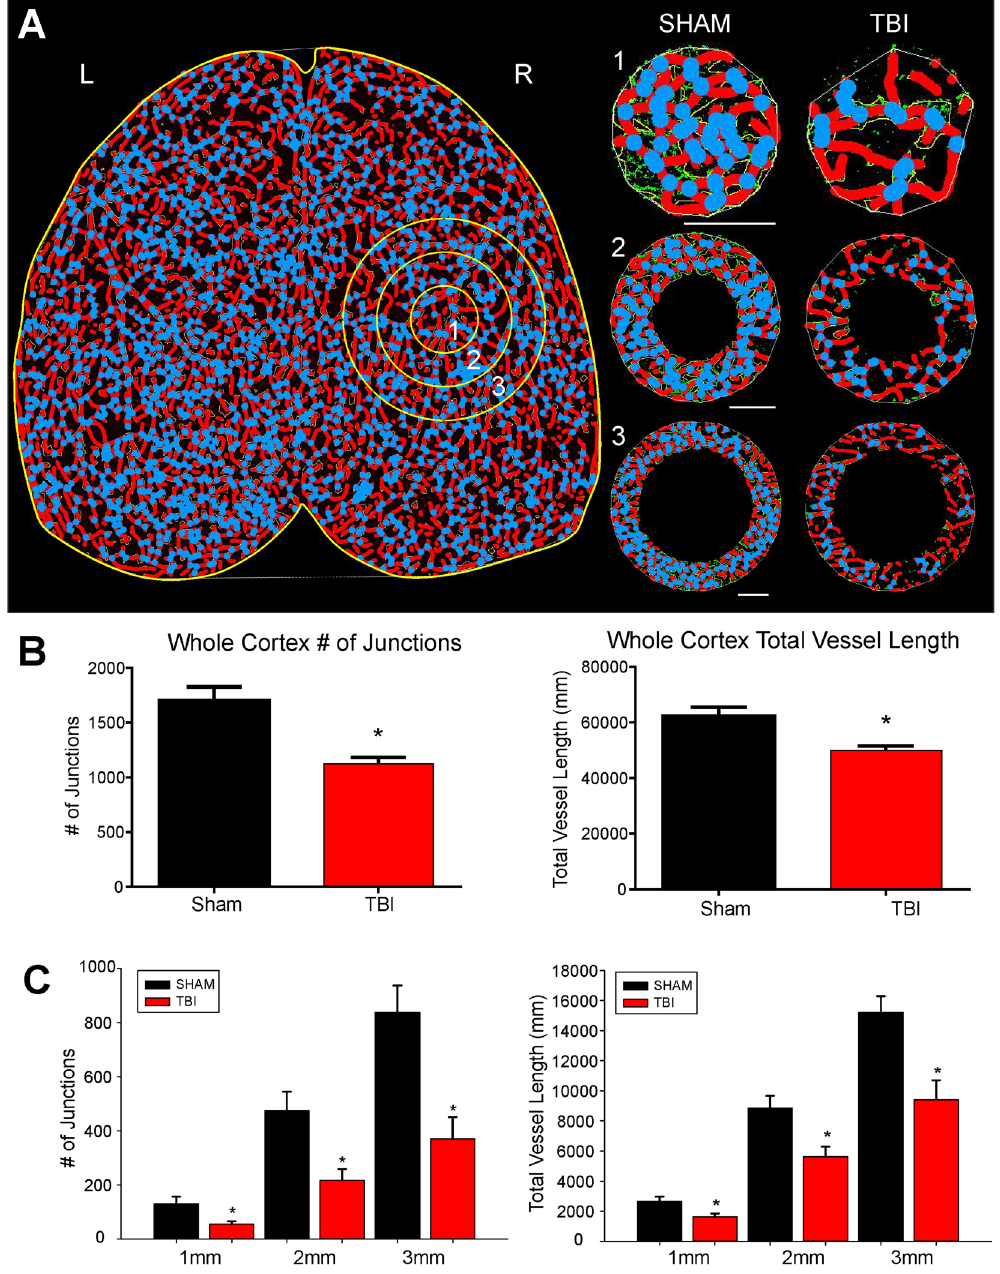
Figure 3. Classical vascular analysis reveals a decrease in the number of junctions and total vessel length following TBI. ( A ) An axial AngioTool image where vessels (red) and junctions (blue) are displayed. Whole cortex and specific concentric radial ROIs projecting outward from the injury site (circles 1–3), were analyzed to quantify vascular alterations. TBI animals exhibited a decrease in the number of vessel junctions and length, even moving outward from the site of injury (1–3 mm). ( B ) Analysis of the entire whole cortex demonstrated a significant reduction in the both number of junctions (t-test, p < 0.05) and in the total vessel length (t-test, p < 0.05) in TBI animals compared to sham animals. ( C ) TBI animals also exhibited a significant decline in the number vascular junctions moving radially outward from the injury site (ROIs 1 to 3) (t-test, p < 0.05). A similar finding was also found in TBI animals where a significant decline in total vessel length moved radially outward from the injury site compared to sham animals (t-test, p <